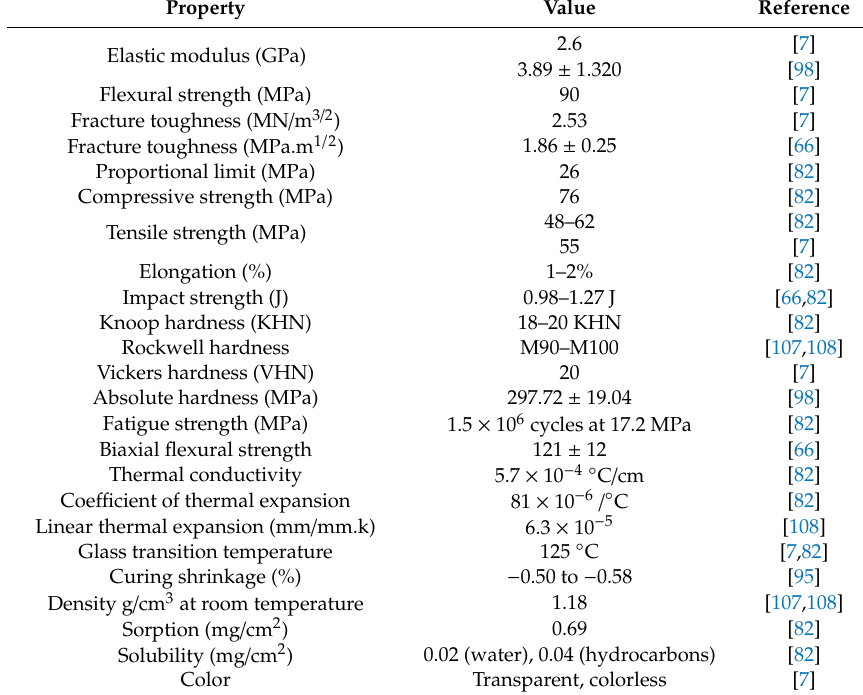
Table 4. Various properties of heat-cured PMMA.